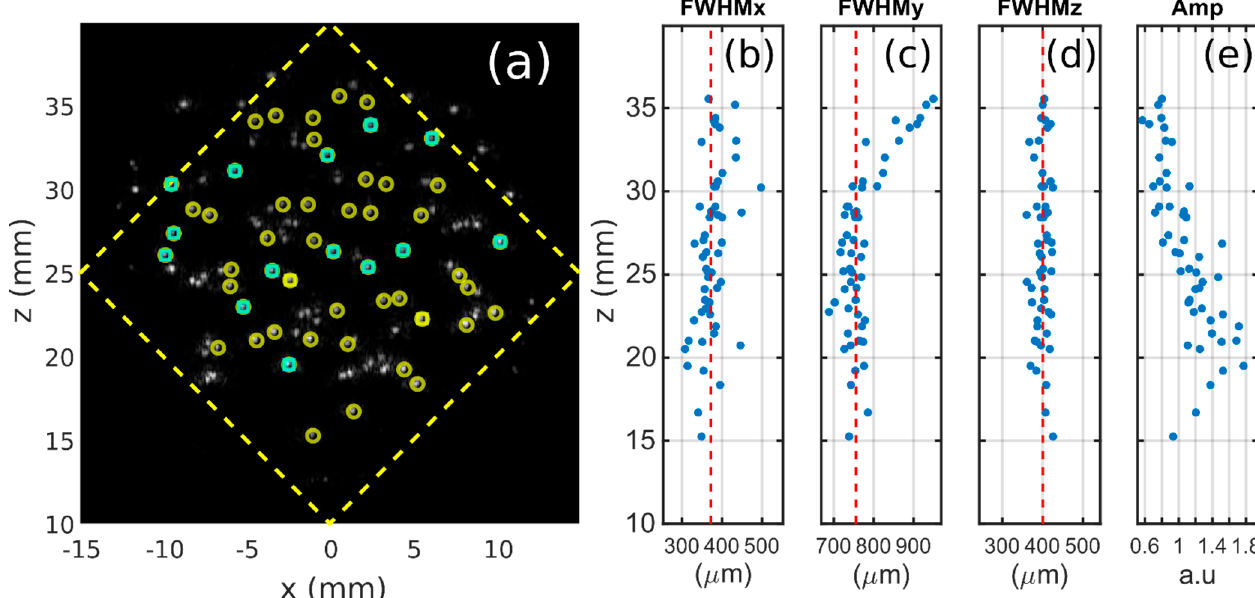
Figure 5. ( a ) MAP image along the y-axis of Ph1 for Δ α 2 in straight transmit. A linear gray scale was used. The 52 microspheres selected for the analysis are emphasized with yellow circular markers and the 16 microspheres kept for resolution estimations in translation-only mode are additionally emphasized with square cyan markers. ( b – e ): Resolution and amplitude of the 52 microspheres in the image are shown as a function of the z-coordinate. The red-dotted lines indicate the median values. For each FWHM graph, the range of abscissa is equal to 300 µm. Table 2. Full width at half maximum (FWHM) along the three directions of the coordinate system for microspheres of Ph1. Values are median ± interquartile range (IQR). Two acquisition modes are compared: a rotate-translate scan at ∆ α 2 (data set of 52 microspheres) and a translation-only scan (data set of 16 microspheres). The translation range was L = 30 mm for both acquisition modes. FWHM Axis of